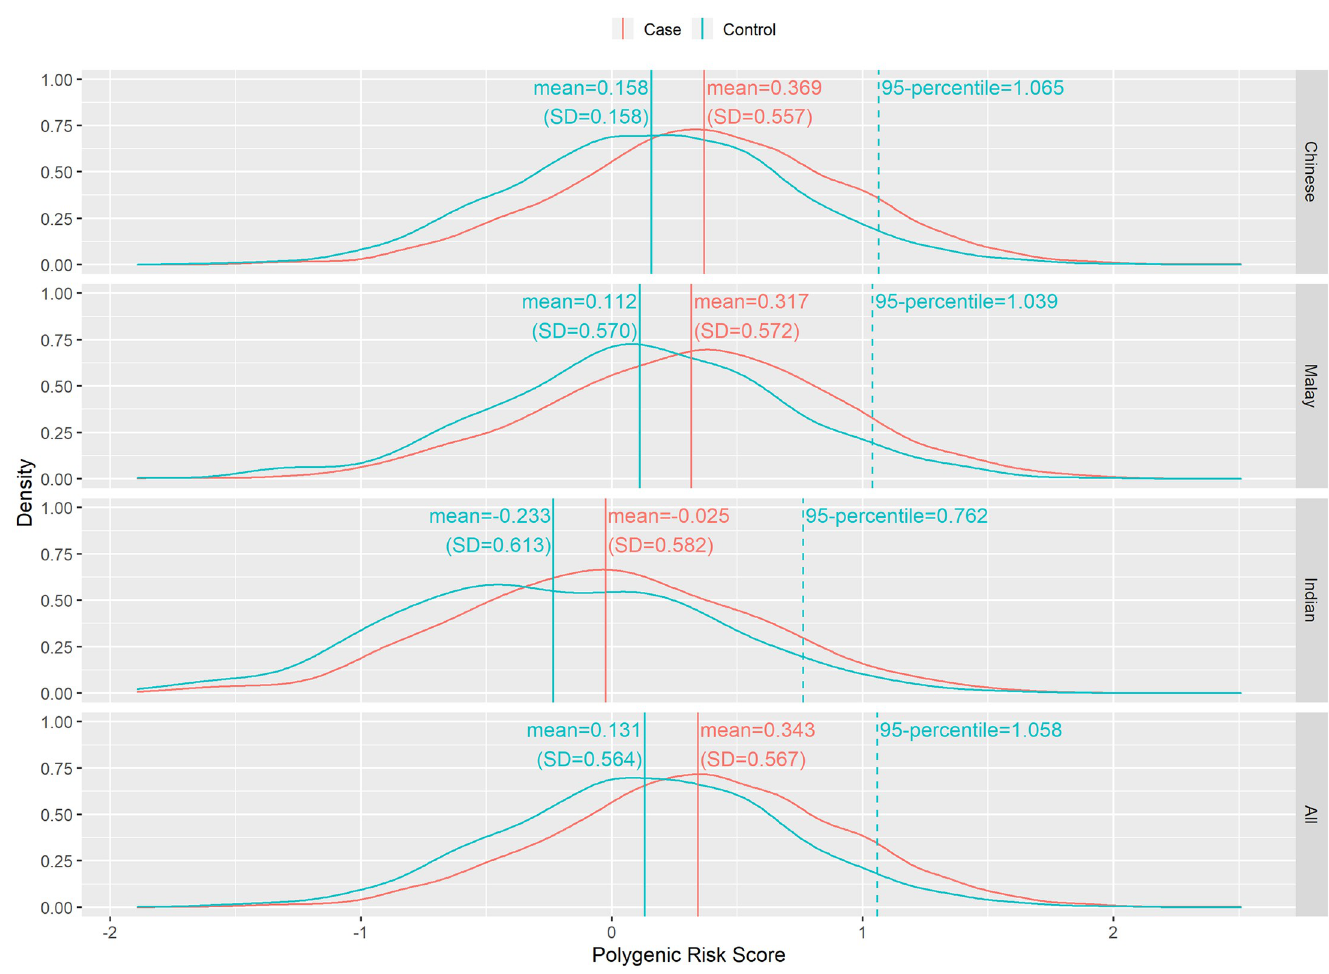
Fig 4. Distribution of polygenic risk scores for cases and controls by ethnicity groups. S1 Fig. Subject recruitment chart of the Singapore Breast Cancer Cohort (SGBCC) study. Breast cancer patients are approached by trained research coordinators during their outpatient (English, Chinese or Malay). Over an in-person interview with a research coordinator, partici-